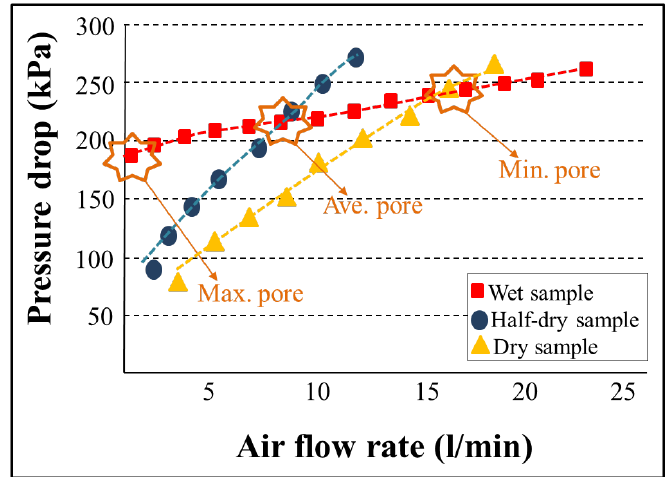
Figure 4. Example of a pressure drop determination to calculate the pore size.